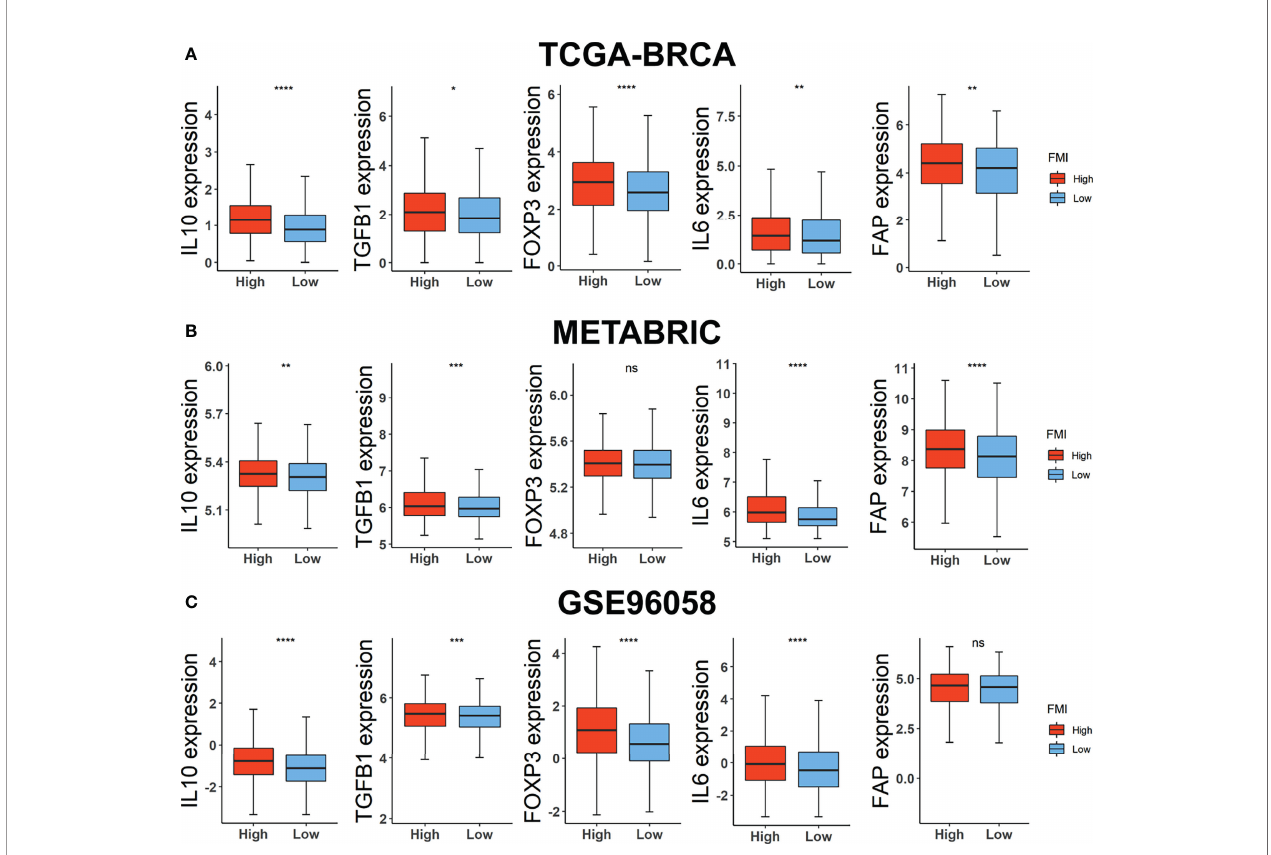
FIGURE 7 | Investigations of TME immunosuppressive cytokines and markers. Expression level of IL10, TGF- b , FOXP3, IL6, and FAP in TCGA-BRCA (A) , METABRIC (B) , and GSE96058 (C) datasets. TME, tumor microenvironment; TCGA, The Cancer Genome Atlas; METABRIC, Molecular Taxonomy of Breast Cancer International Consortium. * Means p < 0.05; ** means p < 0.01; *** means p < 0.001; **** means p < 0.0001; ns means no signi fi